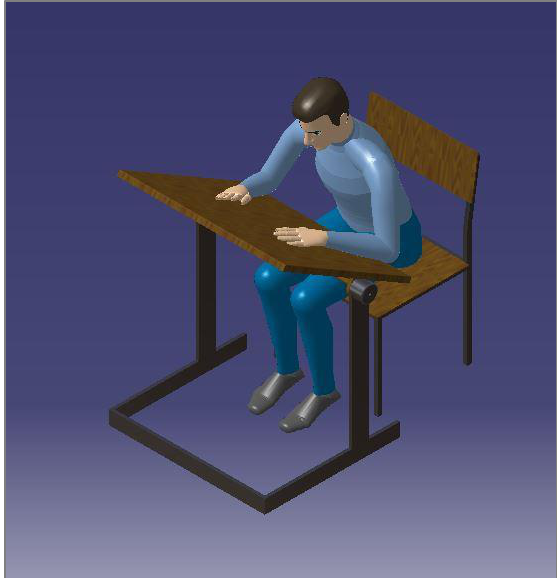
Figure 1. CATIA computer model and typical body position of the